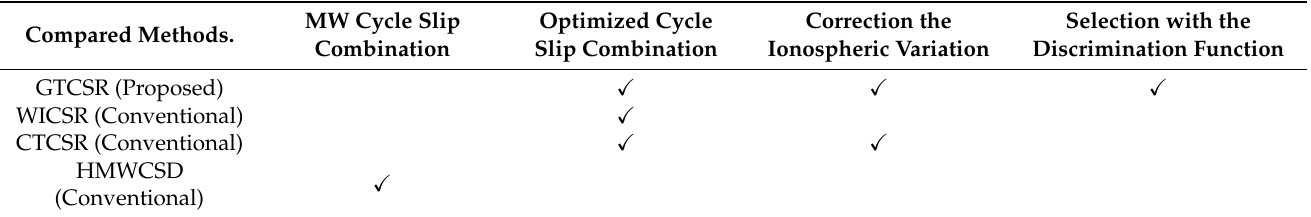
Table 4. The comparison of the different testing